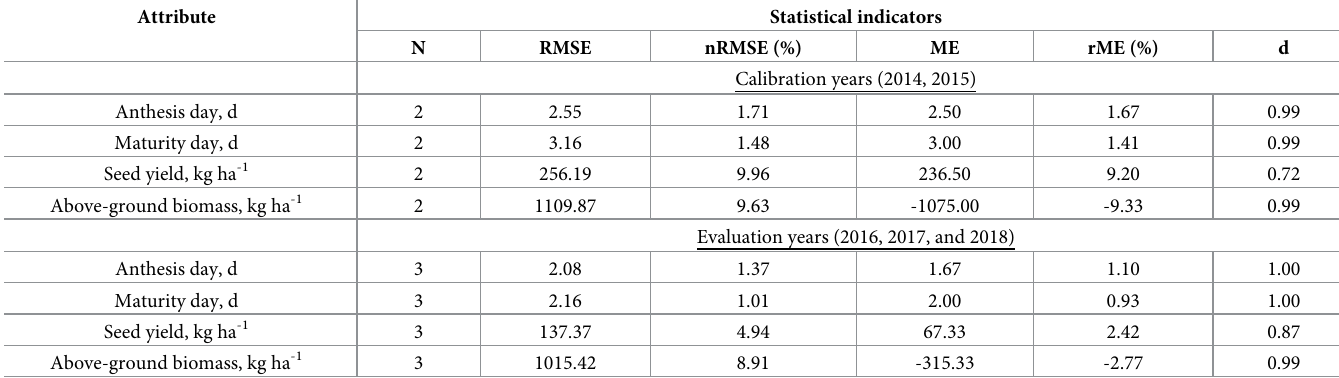
Table 8. Statistical indicators for calibration and evaluation of the model.